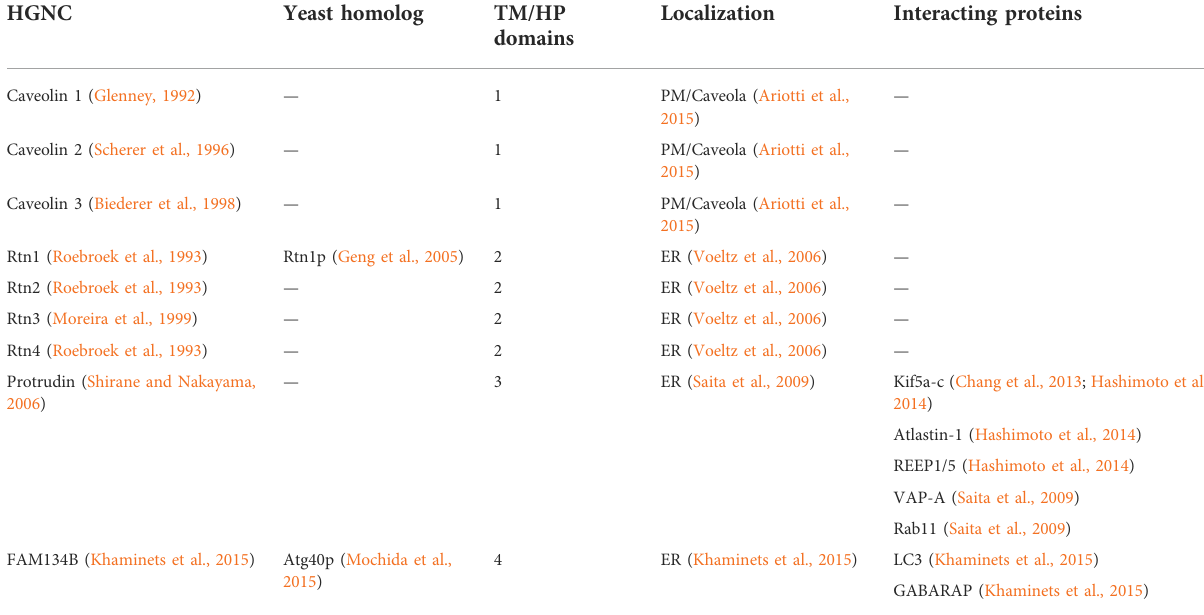
TABLE 8 Other potential membrane-shaping adaptor proteins (MSAPs).